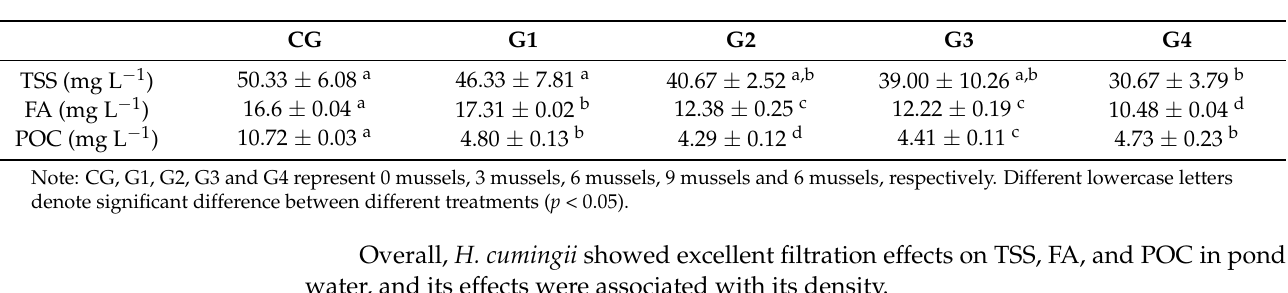
Table 1. Total suspended solids (TSS), fatty acid (FA), and particulate organic carbon (POC) in different mussel density